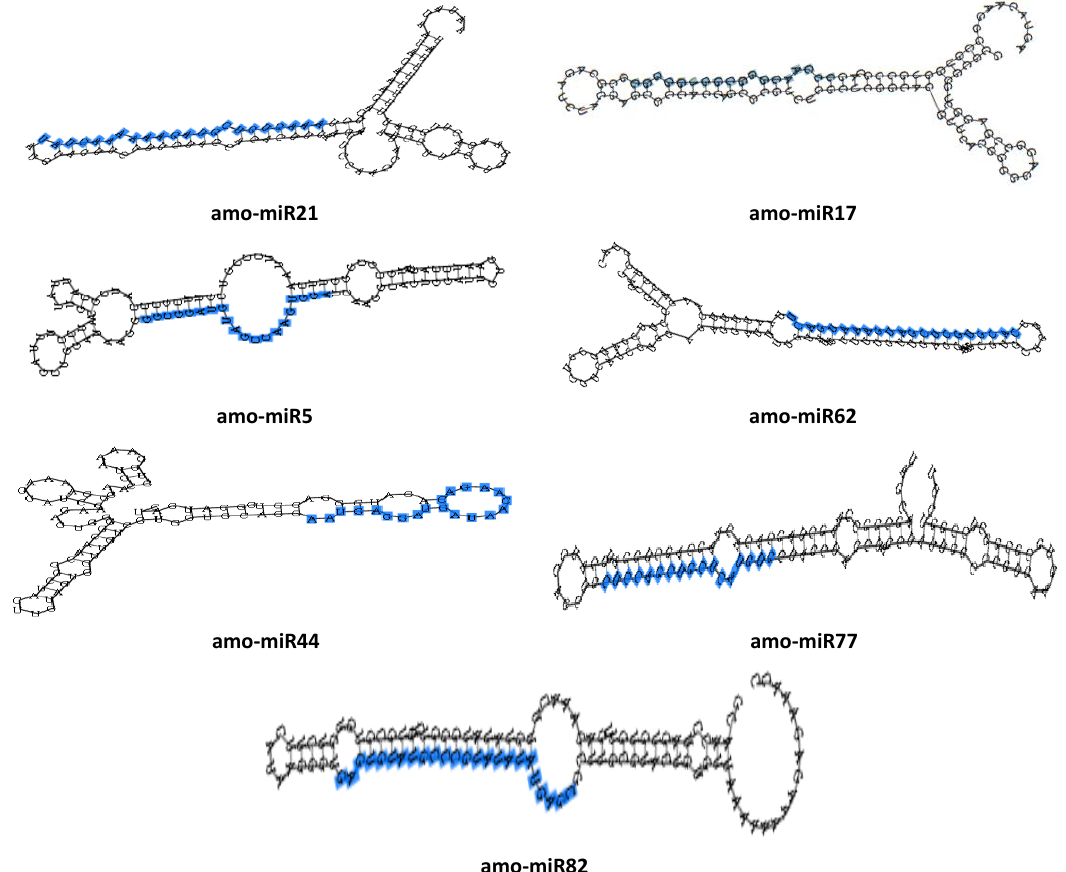
Figure 2. Secondary structure of seven novel miRNAs identified in A. Mongolicum.